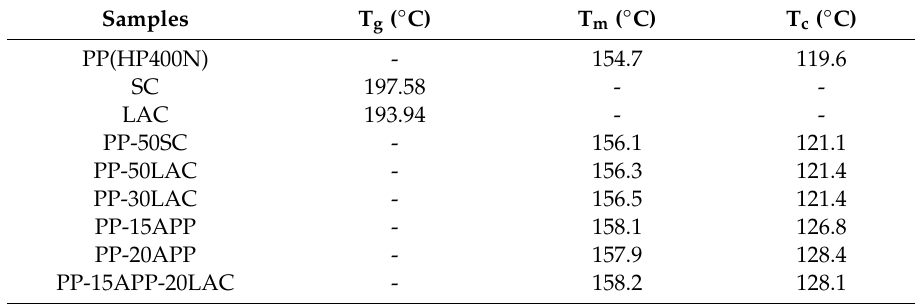
Figure 2. The heating ( a ) and cooling ( b ) curves of neat PP, PP–casein, and PP-ammonium Figure2. Theheating( a )andcooling( b )curvesofneatPP,PP–casein, andPP-ammoniumpolyphosphate polyphosphate (APP) composite samples. (APP) composite samples. Table 2. Di ff erential scanning calorimetry (DSC) data information about neat PP, casein (LAC / SC), and Table 2. Differential scanning calorimetry (DSC) data information about neat PP, casein (LAC/SC), PP composite and PP composite samples.